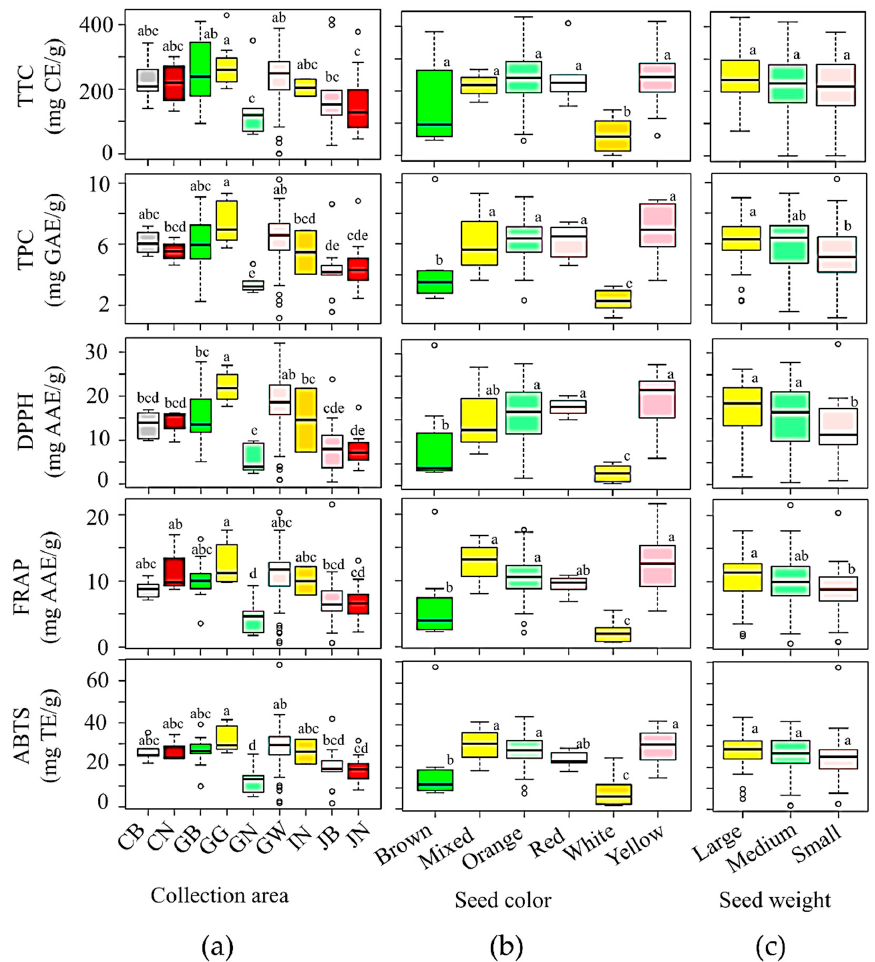
Figure 3. Variations in metabolite contents and antioxidant activities in sorghum landraces according to the collection area, seed color and seed weight. Different letters on box plots in a category show significantly different means. ABTS: 2,2 ′ -azino-bis(3-ethylbenzothiazoline-6-sulfonic acid) di-